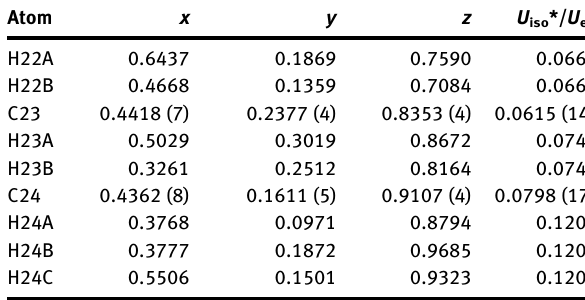
Table  : Fractional atomic coordinates and isotropic or equivalent isotropic displacement parameters (Å 